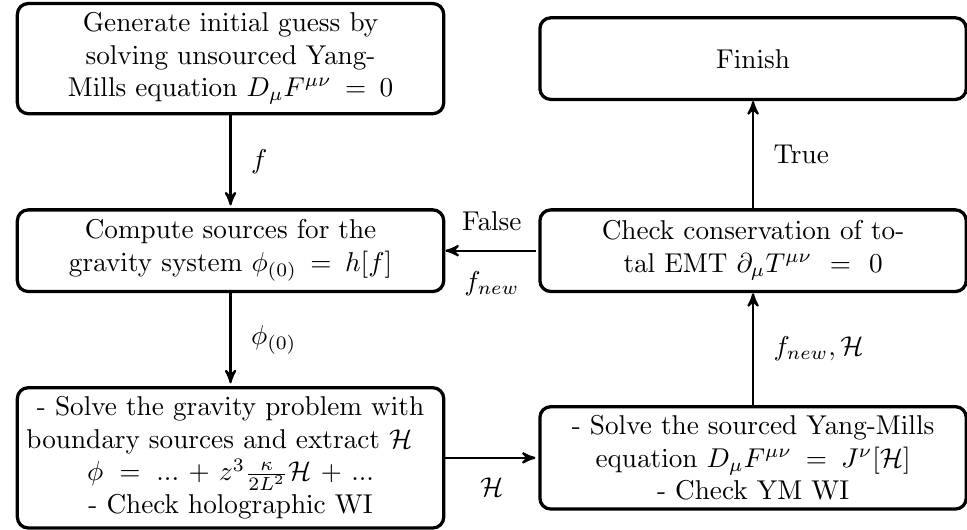
Figure 1 . Flow chart of the iterative procedure explained in the main